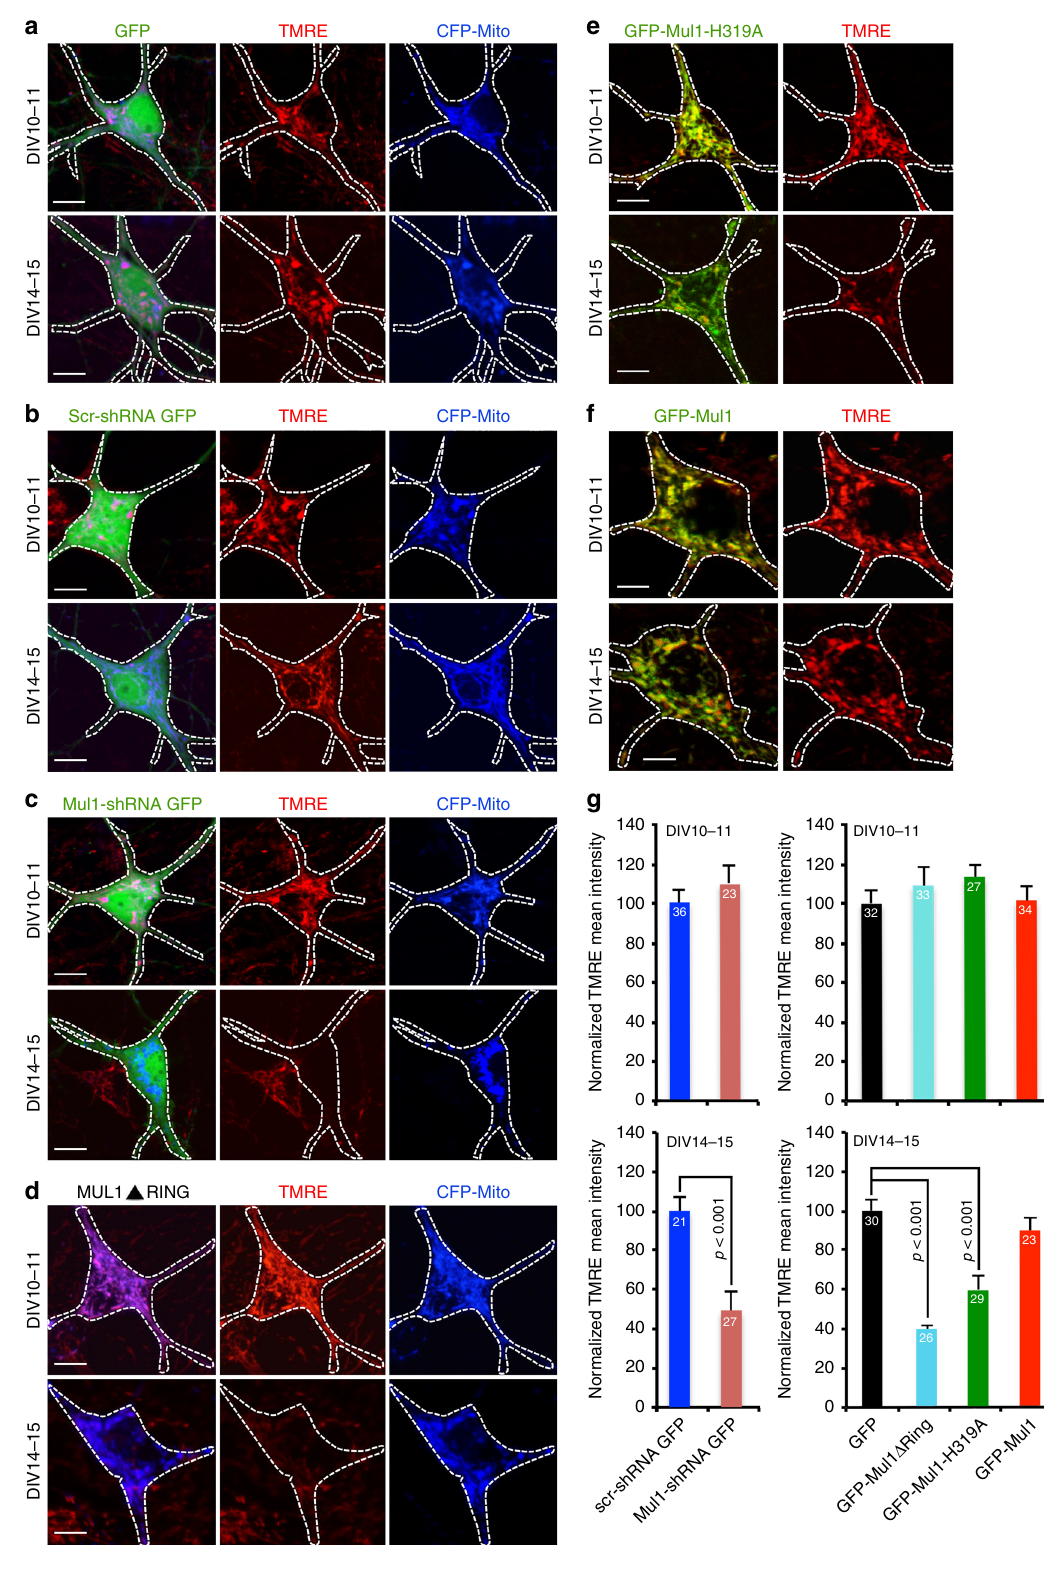
con fi rmed mitochondria-targeting of PTPIP51 in neurons (Fig. 9a). Second, by tracing the average fl uorescence ratio (Fig. 9b) and measuring mitochondrial Ca 2 + peak ratio (525 nm/458 nm) (Fig. 9c) following stimulation with 10 μ M histamine, we found a partial rescue of mitochondrial Ca 2 +